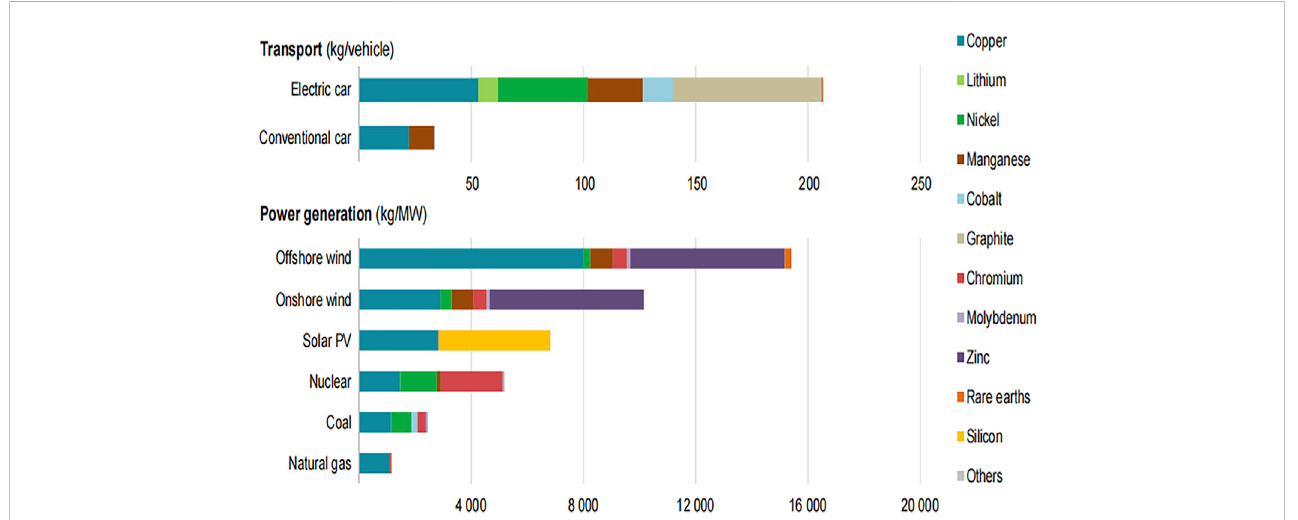
FIGURE 1 Mineral resources used in clean energy transformation 1 .